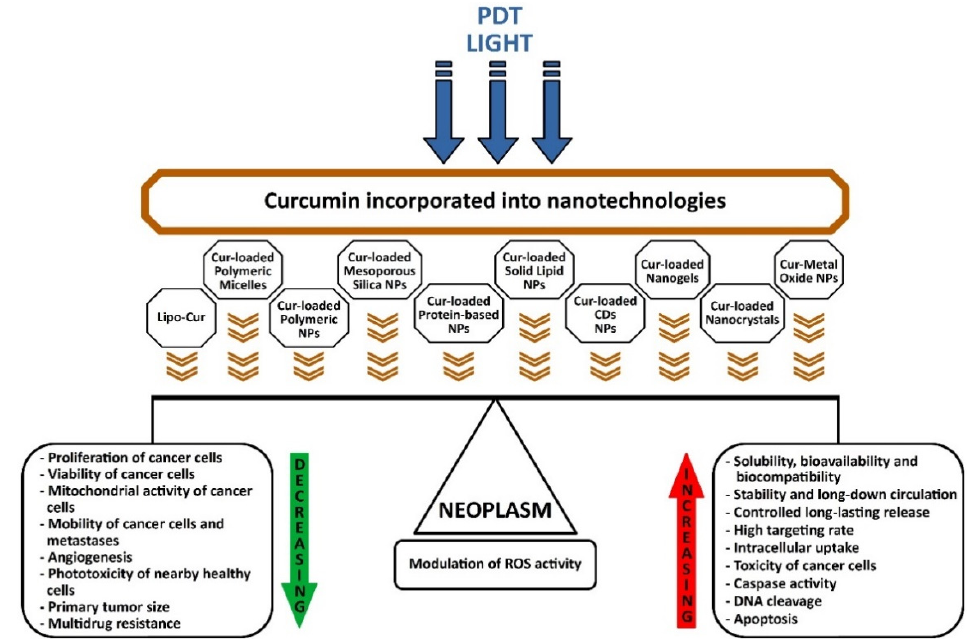
Figure 4. Effects of latest innovations and nanotechnologies with curcumin applied in the photodynamic therapy (PDT) of cancer.